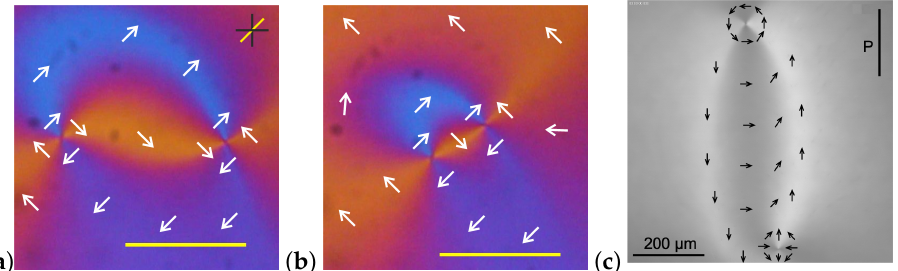
Figure 2. Snapshots of two defect pairs: The + 1 defect has always tangential orientation of the c- director near the core. The − 1 defect is initially rotated respective to the partner (in mismatch) so that the director field along a straight line connecting the cores is not uniform. Image ( a ) was recorded 16 s before annihilation. During the mutual approach, the mismatch angle gradually reduces to zero. This state is almost reached in image ( b ), 3 s before annihilation. Yellow bars symbolize 50 µ m. Images were recorded in polarized light with crossed polarizers (black lines) and a diagonal wave plate (slow axis: diagonal yellow line). Bluish regions characterize the c-director in northeast or southwest direction, while orange regions indicate a c-director orientation in southeast or northwest directions. In magenta regions, the c-director is either horizontal or vertical in the images. ( c ) Defects pair observed in fluorescence mode (top: +1 defect, bottom: − 1 defect). The black arrows sketch the c-director. The polarizer orientation is indicated by a black bar. Images ( a , b ) are courtesy of Péter Salamon and Kirsten